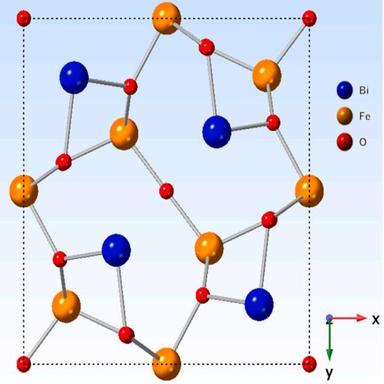
The crystal structure of Bi2Fe4O9.